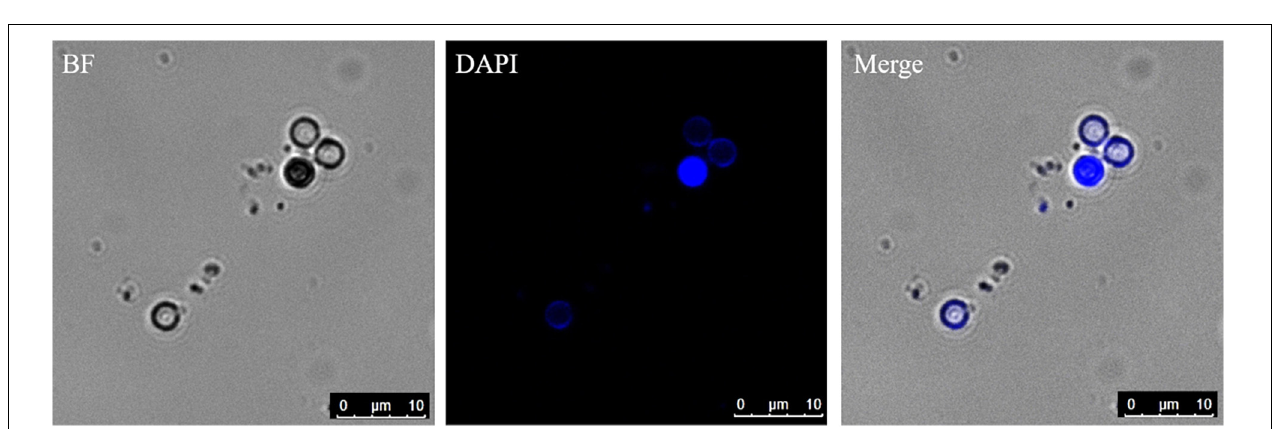
FIGURE 9 | Resting spores of Plasmodiophora brassicae under the optical microscope with DIC prism. (A) Resting spores and conjugated spores; (B,C) emerged “papilla”; (D) germinating spore; (E) primary zoospore; (F) empty case; (G) germinated and non-germinated spores, white arrows indicate germinated spores (GS), black arrows indicate non-germinated spores (NS).